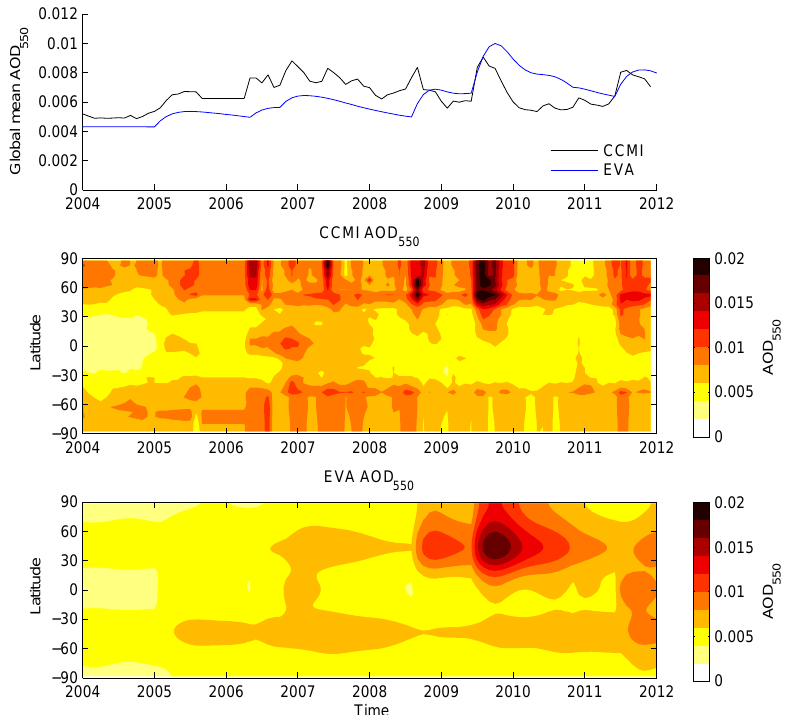
Figure 15. Aerosol optical depth over the period 2004–2012 from the CCMI data set and from EVA, using the volcanic eruption history of Table 1. Top: global mean AOD at 550nm from the two reconstructions. Bottom two panels: zonal mean AOD at 550nm as a function of latitude and